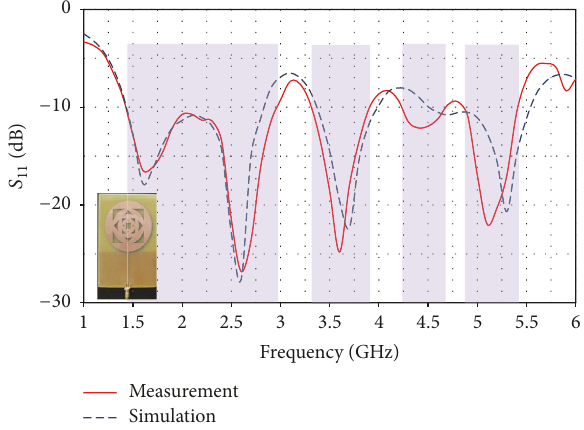
Figure 10: Measured and simulated 𝑆 11 of the